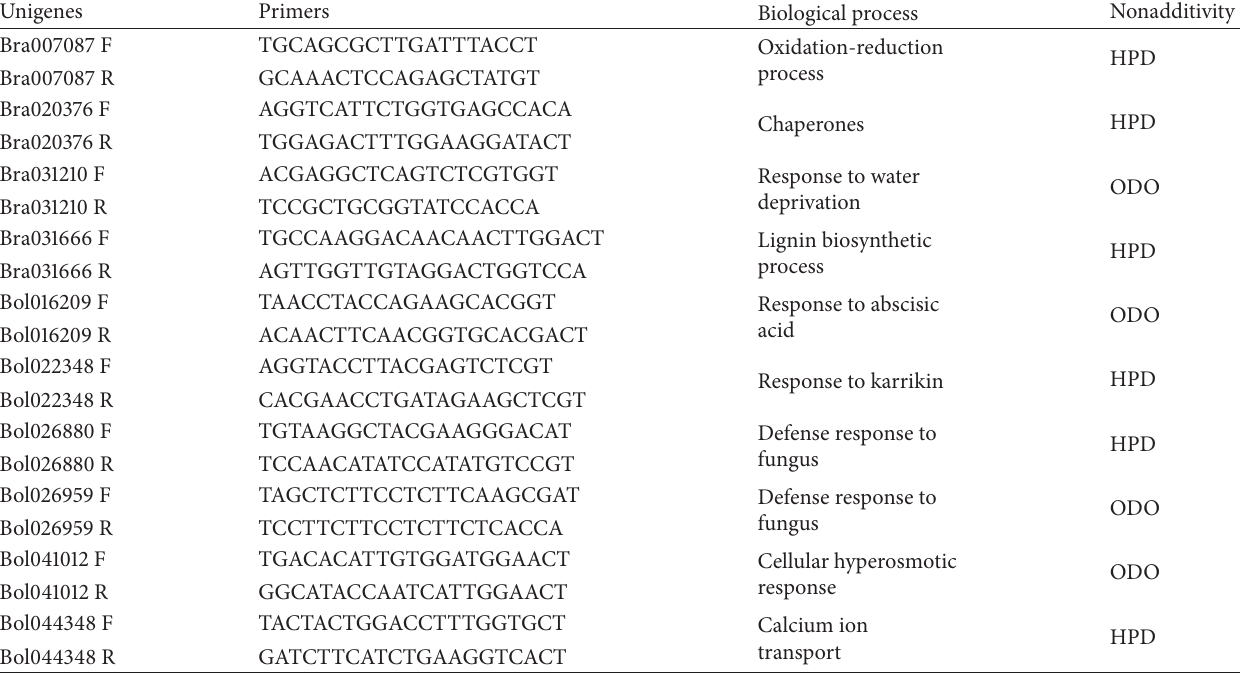
Table 4: The qPCR primers for selected